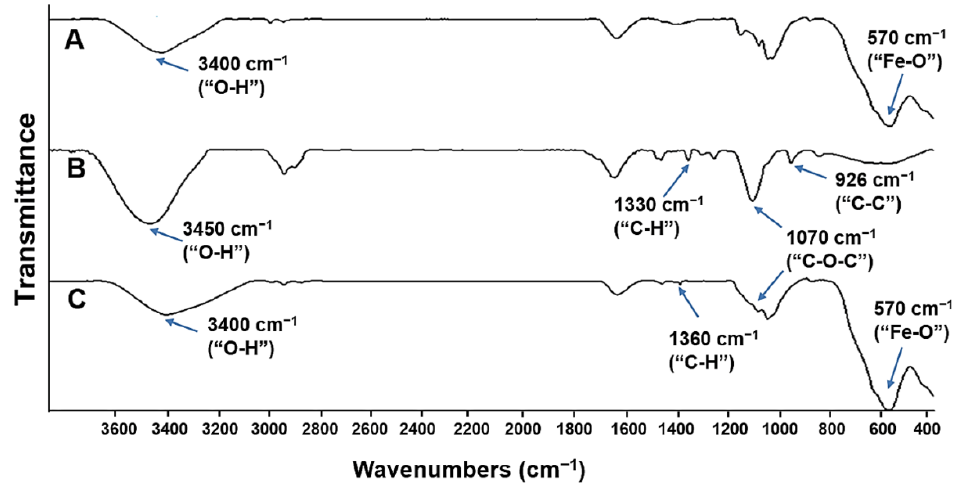
Figure 4. Fourier transform infrared spectroscopy (FT-IR) spectrum of ( A ) starch–IONPs, ( B ) PEG, and ( C ) PEG–starch–IONPs. In each spectrum, the characteristic peaks were displayed with arrows.